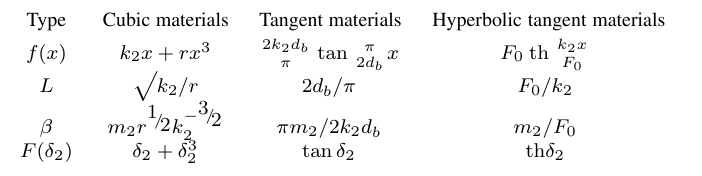
Table 1 The restoring force, system parameters of different types of cushioning